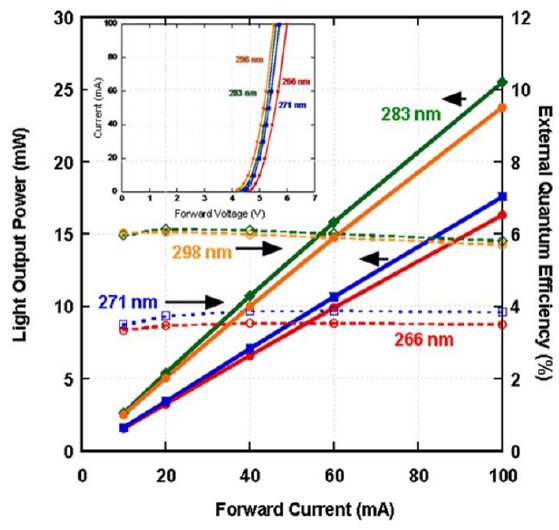
Figure 12. EQEs and I-V characteristics of AlGaN-based DUV-LEDs. The four samples correspond to the solid red circles in Figure 1. (Permitted to be reused from Jpn. J. Appl. Phys. [13]. © Japan Society Applied Physics).